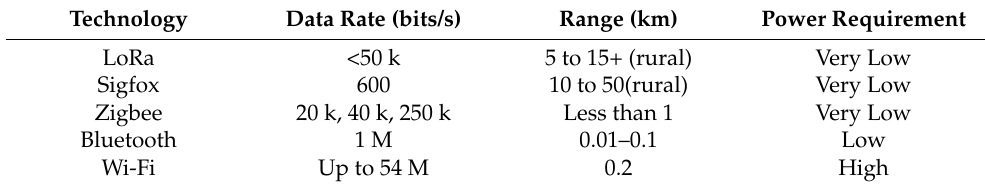
Table 2. Basic features of wireless